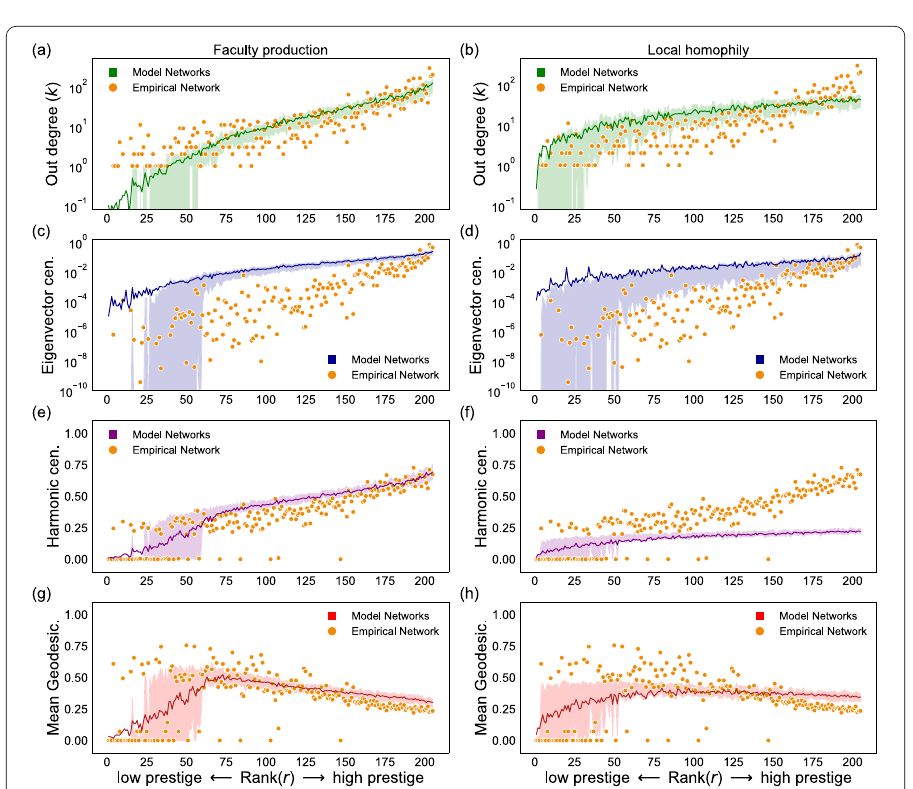
Figure S5 Structural patterns of hiring model networks for two mechanisms of Faculty production and Local homophily and the empirical Computer Science hiring network as a function of prestige. ( a ), ( b ) Out-degree k i , ( c ), ( d ) eigenvector centrality, ( e ), ( f ) harmonic centrality, and ( g ), ( h ) mean geodesic distance normalized by network diameter. Panels on the left ( a ), ( c ), ( e ), ( g ) show results for the Faculty production model, and panels on the right ( b ), ( d ), ( f ), ( h ) show results for the Local homophily model (skewed initialization). Solid lines indicate the mean over 50 simulations, and shaded region around the mean indicates the 25% to 75% quantile range. Orange points indicate the observed values for the Computer Science hiring network. Large rank denotes higher